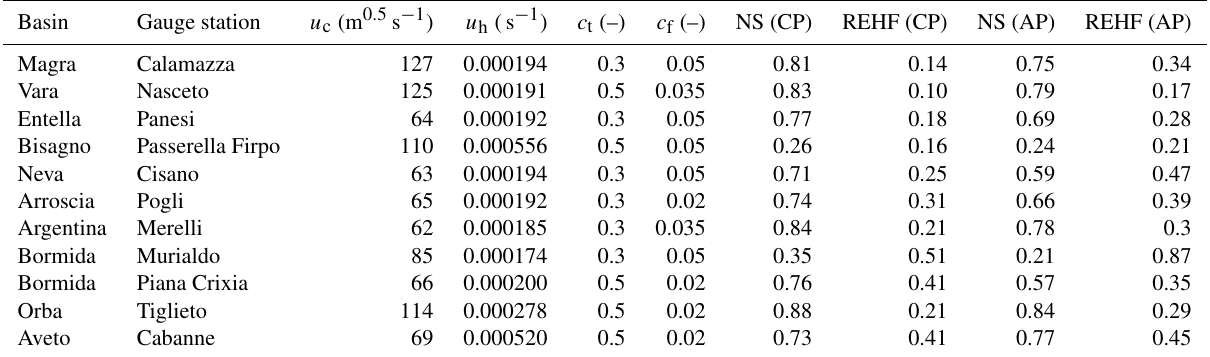
Table 3. Hydrological model validation (1 January 2013 to 31 December 2014); skill score values obtained for the calibrated basins with calibrated (CP) and average (AP) parameters. The values of calibrated parameters are also reported. V Wmax (mm) and R f (–) have values of 500mm and 1 for all the